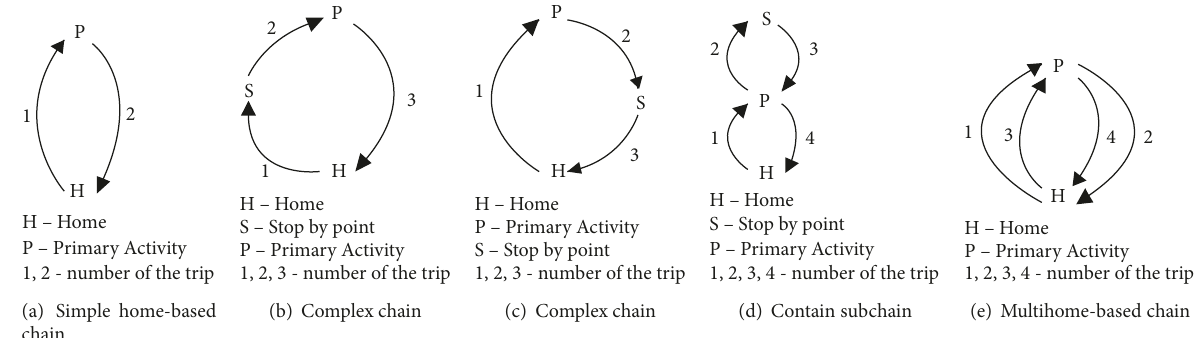
Figure 5: Typical trip-chains for urban